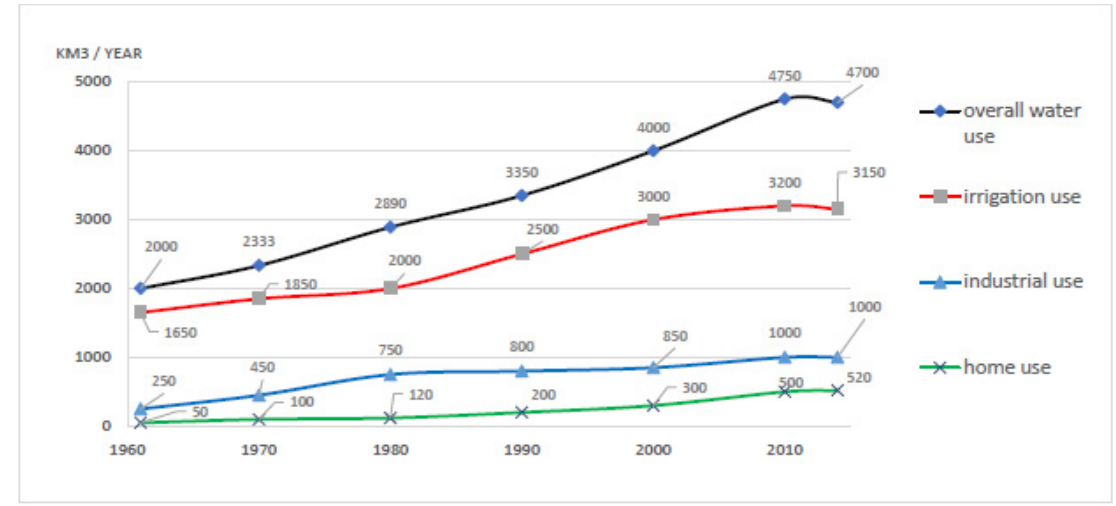
Figure 1. Distribution of global water resources from 1961 to 2014.